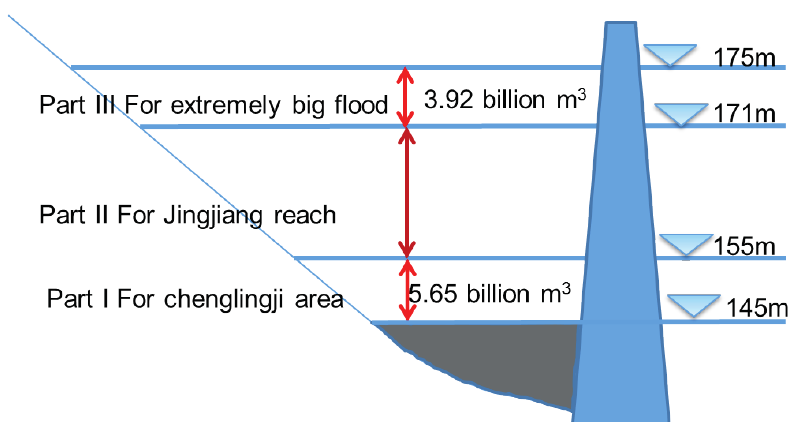
Fig. 5 Allocation of reservoir storage for flood control purposes for different areas